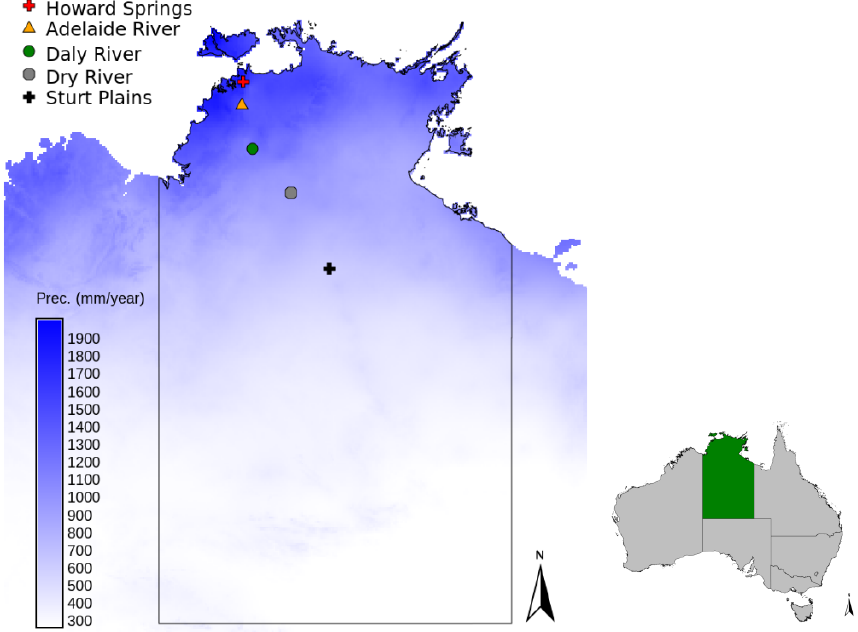
Figure 1. Locations of the study sites along the North Australian Tropical Transect in the Northern Territory of Australia, with the mean annual precipitation shown in the blue colour scale (SILO Data Drill, Jeffrey et al., 2001, calculated for